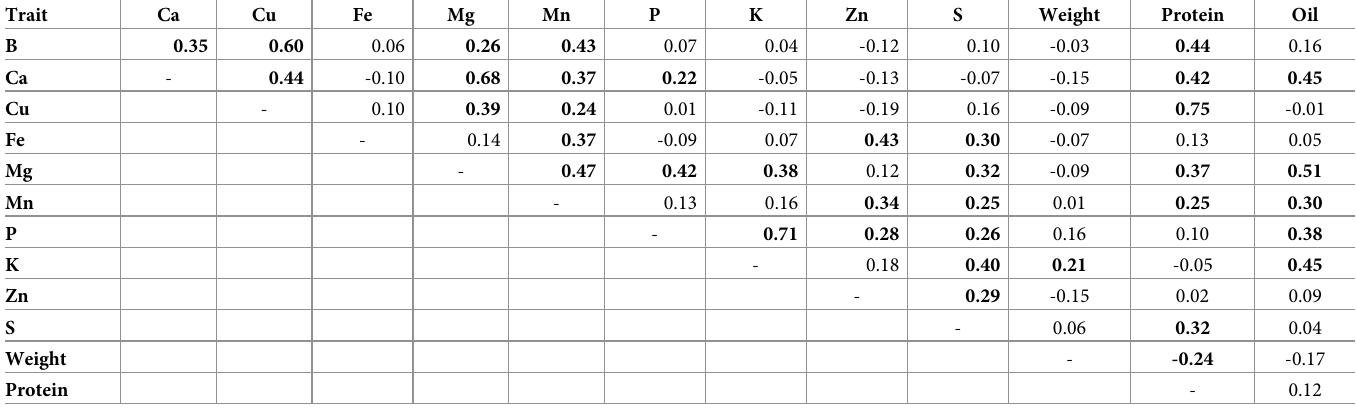
Table 2. Seed trait correlation matrix. Trait